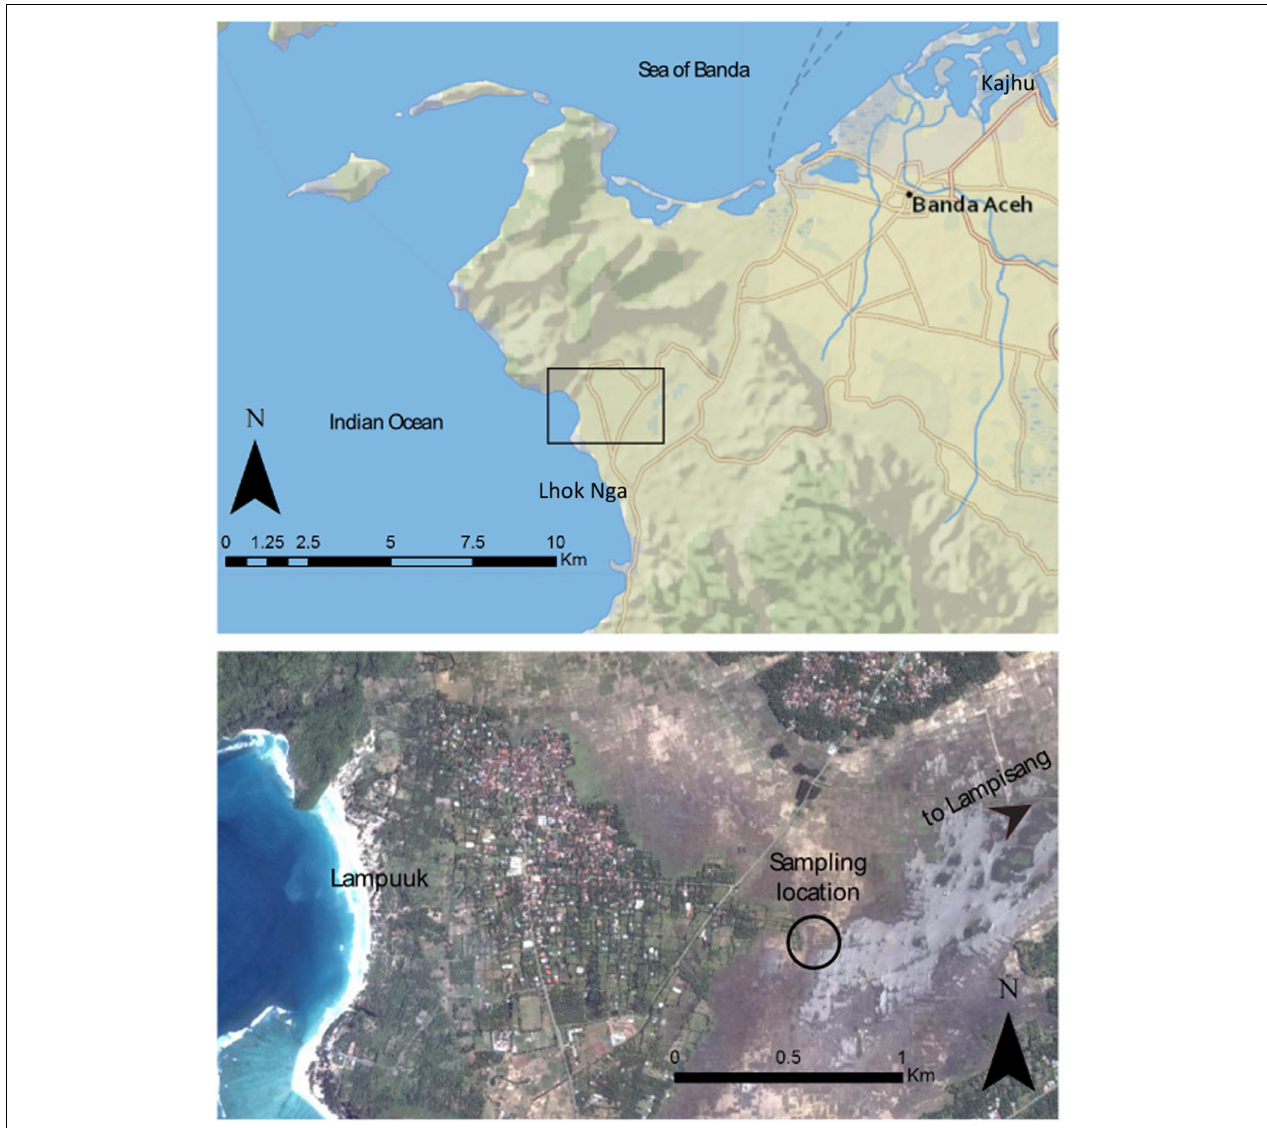
FIGURE 1 | General map of Banda Aceh area, North Sumatra, Indonesia. Black circle corresponds to investigation